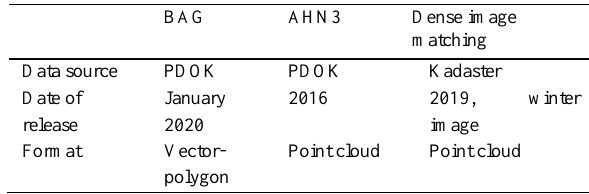
Figure 2. Methodology for the